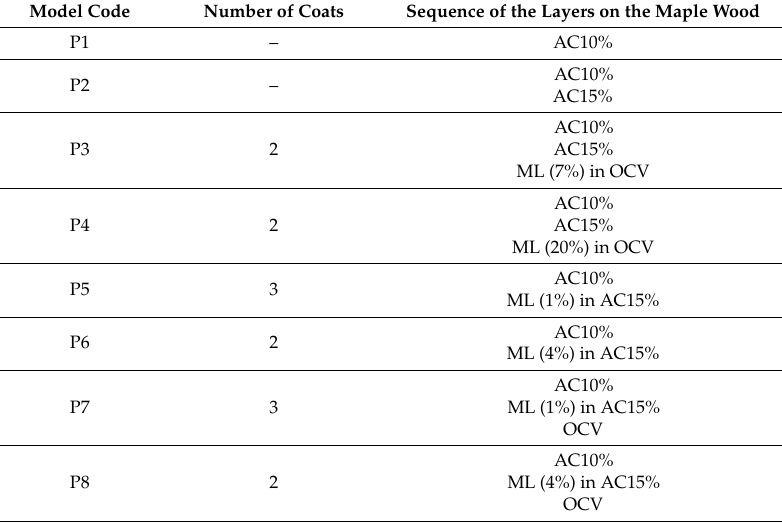
Table 1. Details for the various coating systems prepared on the maple slabs. AC = ammonium caseinate; ML = madder lake; OCV = oil-colophony varnish. The number of coatings refers to the maximum number of subsequent coats of the lake-containing material (AC or